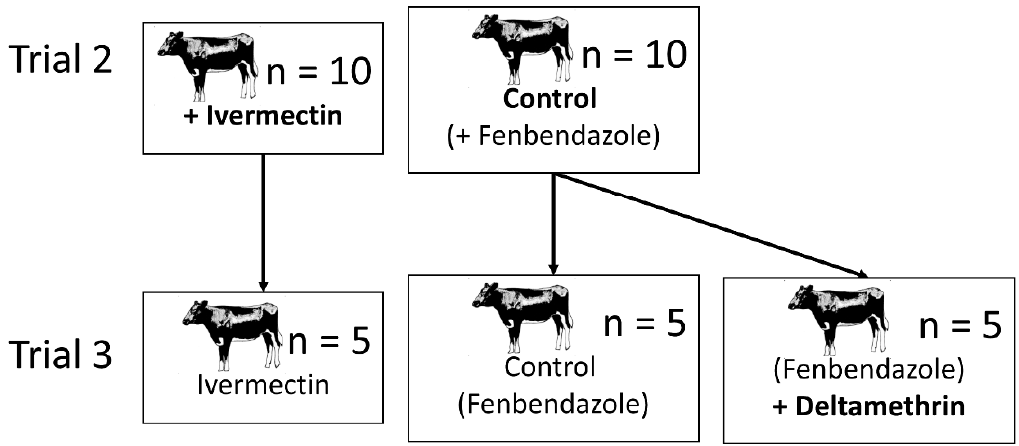
Figure 2. The relationship between the treatments in trial 2 and trial 3. Five heifers selected at random from the trial 2 ivermectin treatment were kept on for trial 3. The 10 heifers in the trial 2 control treatment were split into two groups of five for trial 3. One group was left as a control, whilst the other group was treated with deltamethrin.